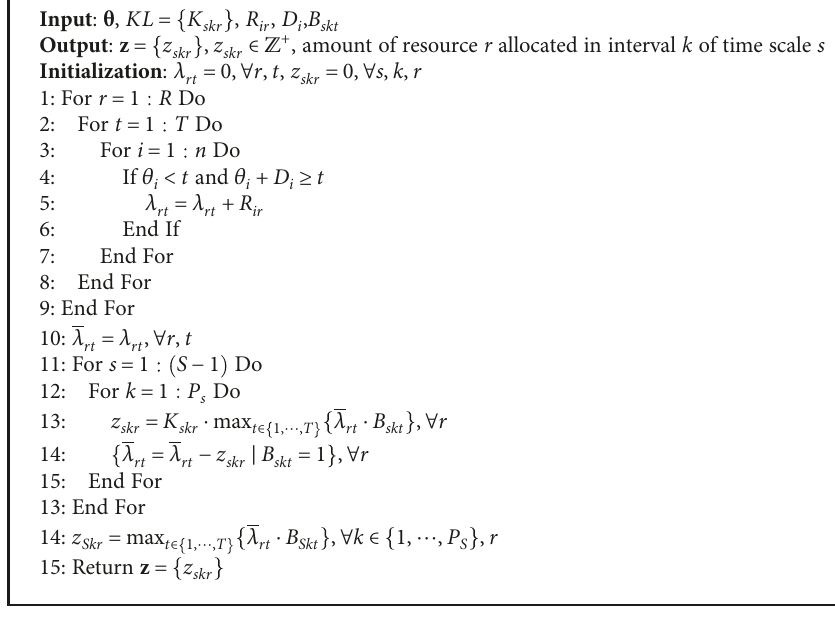
Algorithm 2: Pseudocode of Stage 2.